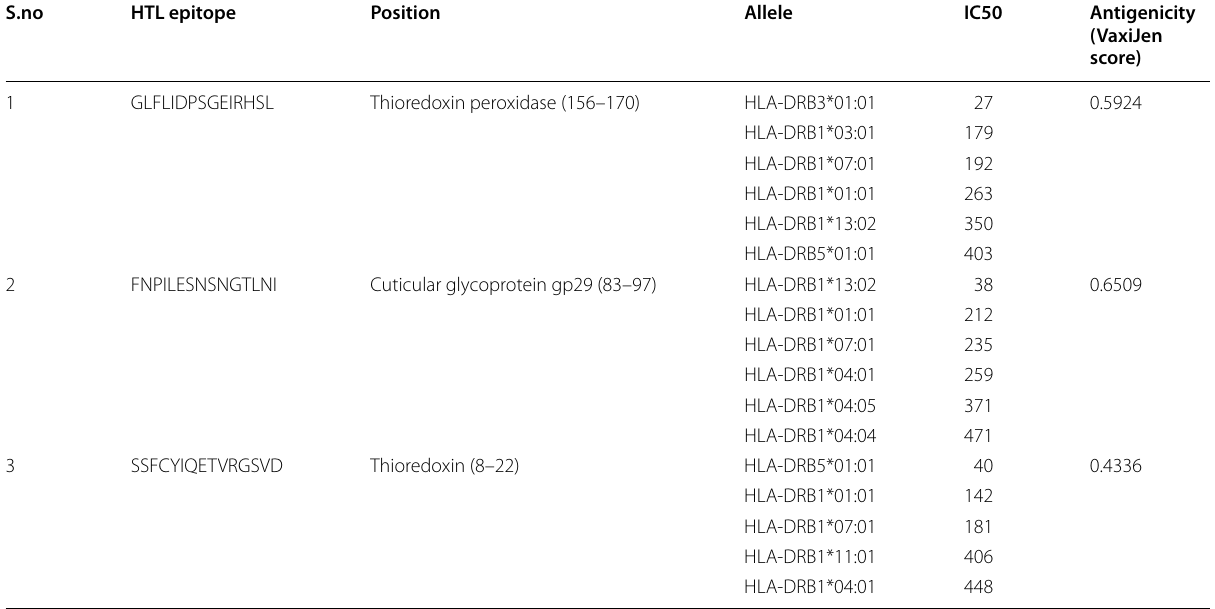
Table 4 T epitopes with its binding allele (IC50 < 500 nM) H